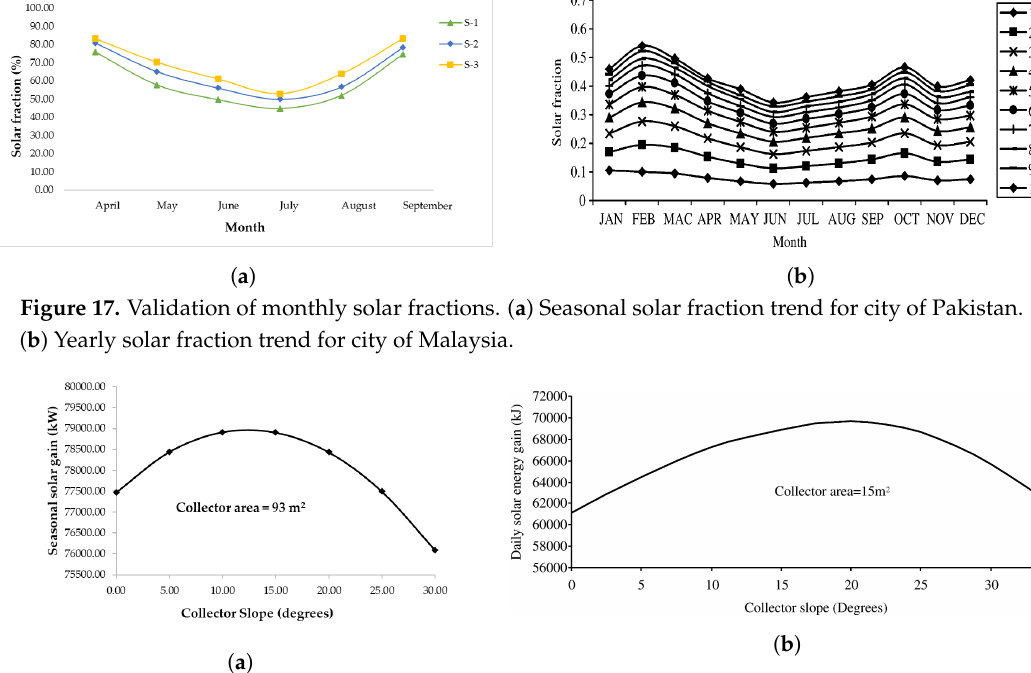
Figure 18. Validation of optimum slope. ( a ) Useful Collector Gain Vs Collector Slope for city of Pakistan. ( b ) Useful Collector Gain Vs Collector slope for city of Malaysia.